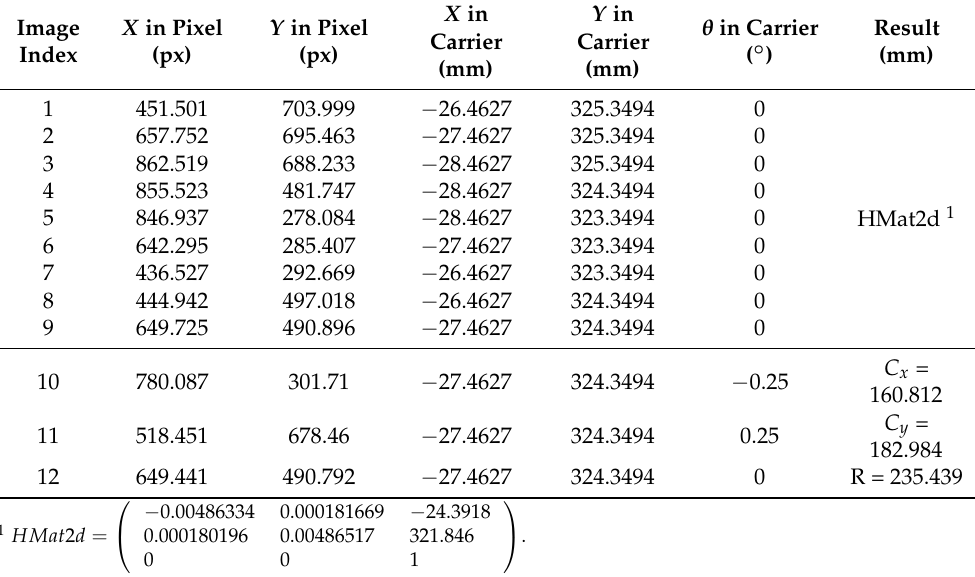
Table 2. The pixel location and the physical location of twelve images and the calibration